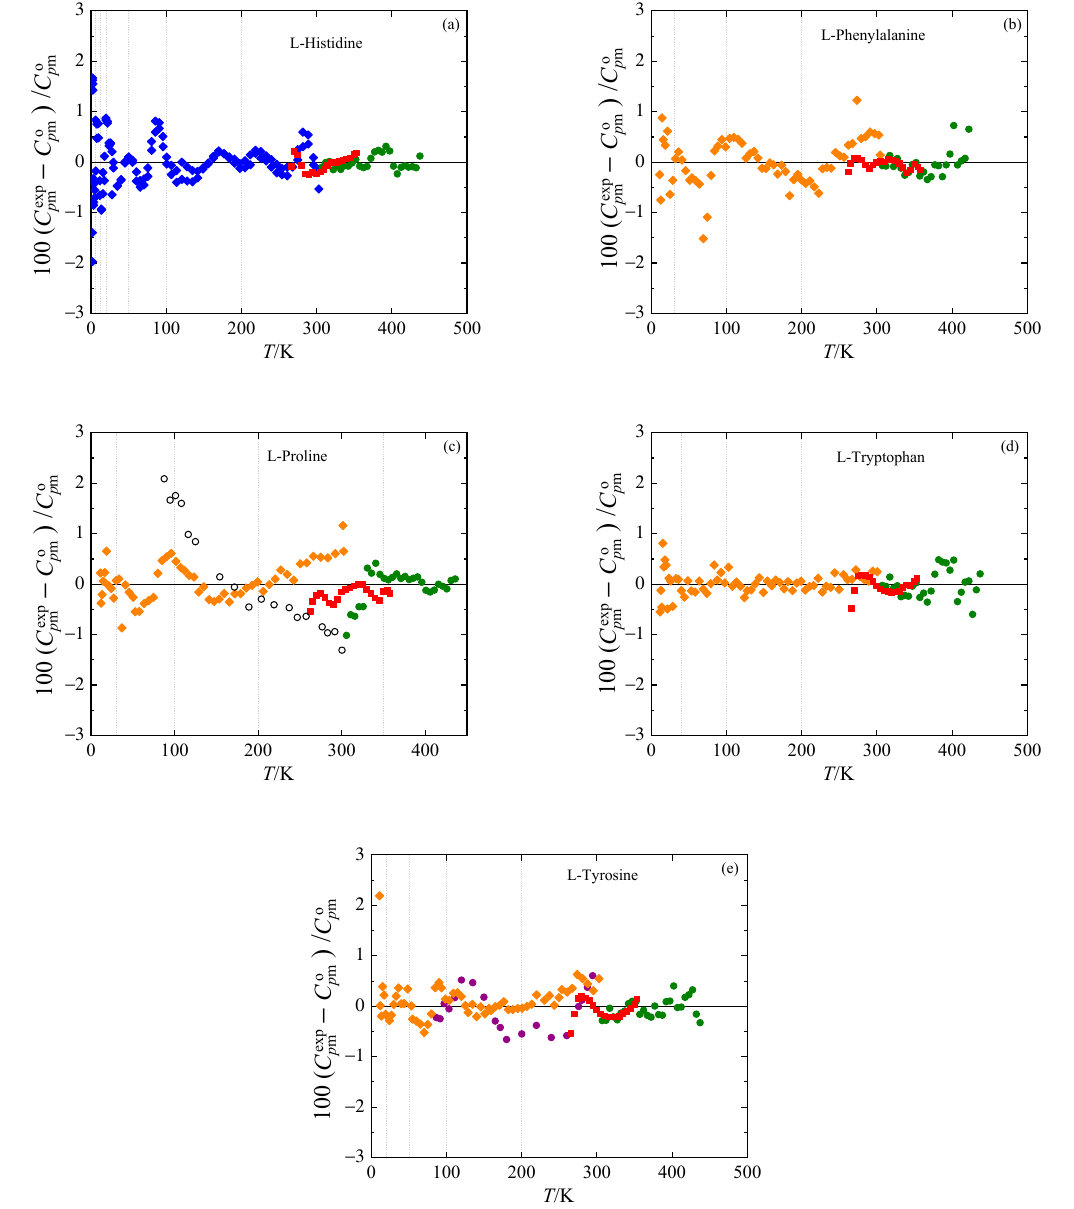
Figure 2. Relative deviations 100 / C o p m of individual experimental heat capacities C exp p m from values C o p m calculated by means of Equations (1) and (2) with parameters from Table 4. ( a ) L -histidine, ( b ) L -phenylalanine, ( c ) L -proline, ( d ) L -tryptophan, and ( e ) L -tyrosine. Blue diamonds: this work (relaxation calorimetry); red squares: this work (Tian–Calvet calorimetry); green circles: this work (power compensation DSC); orange diamonds: Cole et al. [30]; empty circles: Huffman and Fox [32]; purple circles: Huffman and Ellis [31]. Vertical lines denote the knot temperatures T i . The thermodynamic functions derived using Equations (1) and (2) are tabulated in